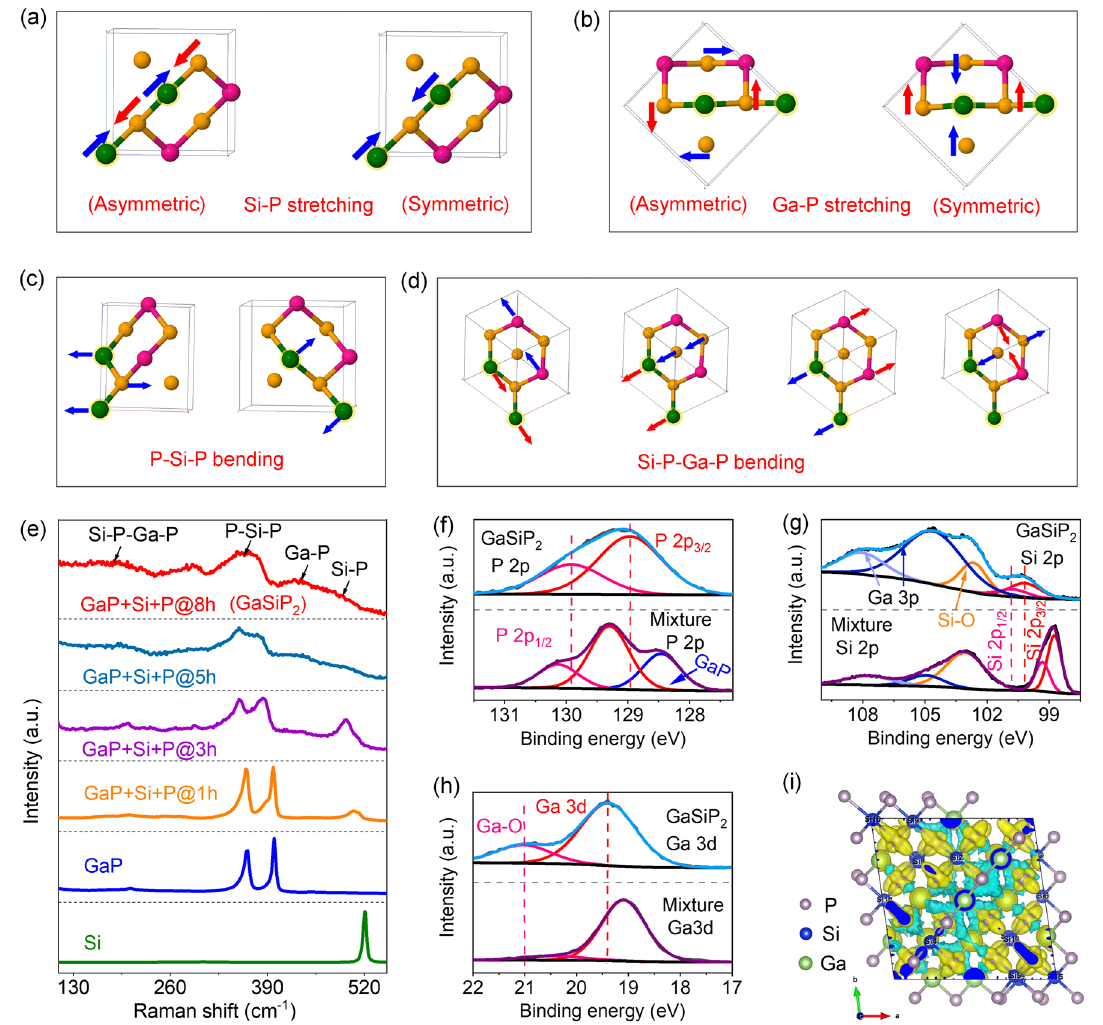
Fig. 3 Raman vibration analysis of the cation-mixed GaSiP 2 : a Si–P, 495–470 cm −1 ; b Ga–P, 430–410 cm −1 ; c P–Si–P, 365–375 cm −1 ; d Si–P– Ga–P, 220–180 cm −1 . (Nate that: the blue and red arrows represent the atomic movements). e Raman spectra of the cation-mixed GaSiP 2 com- pound, ball-milled GaP + Si + P intermediates, GaP, and Si. High-resolution XPS spectra of the GaSiP 2 and the mixture of GaP + Si + P: f P 2 p ; g Si 2 p ; h Ga 3 d . i Charge density difference of the cation-mixed GaSiP 2